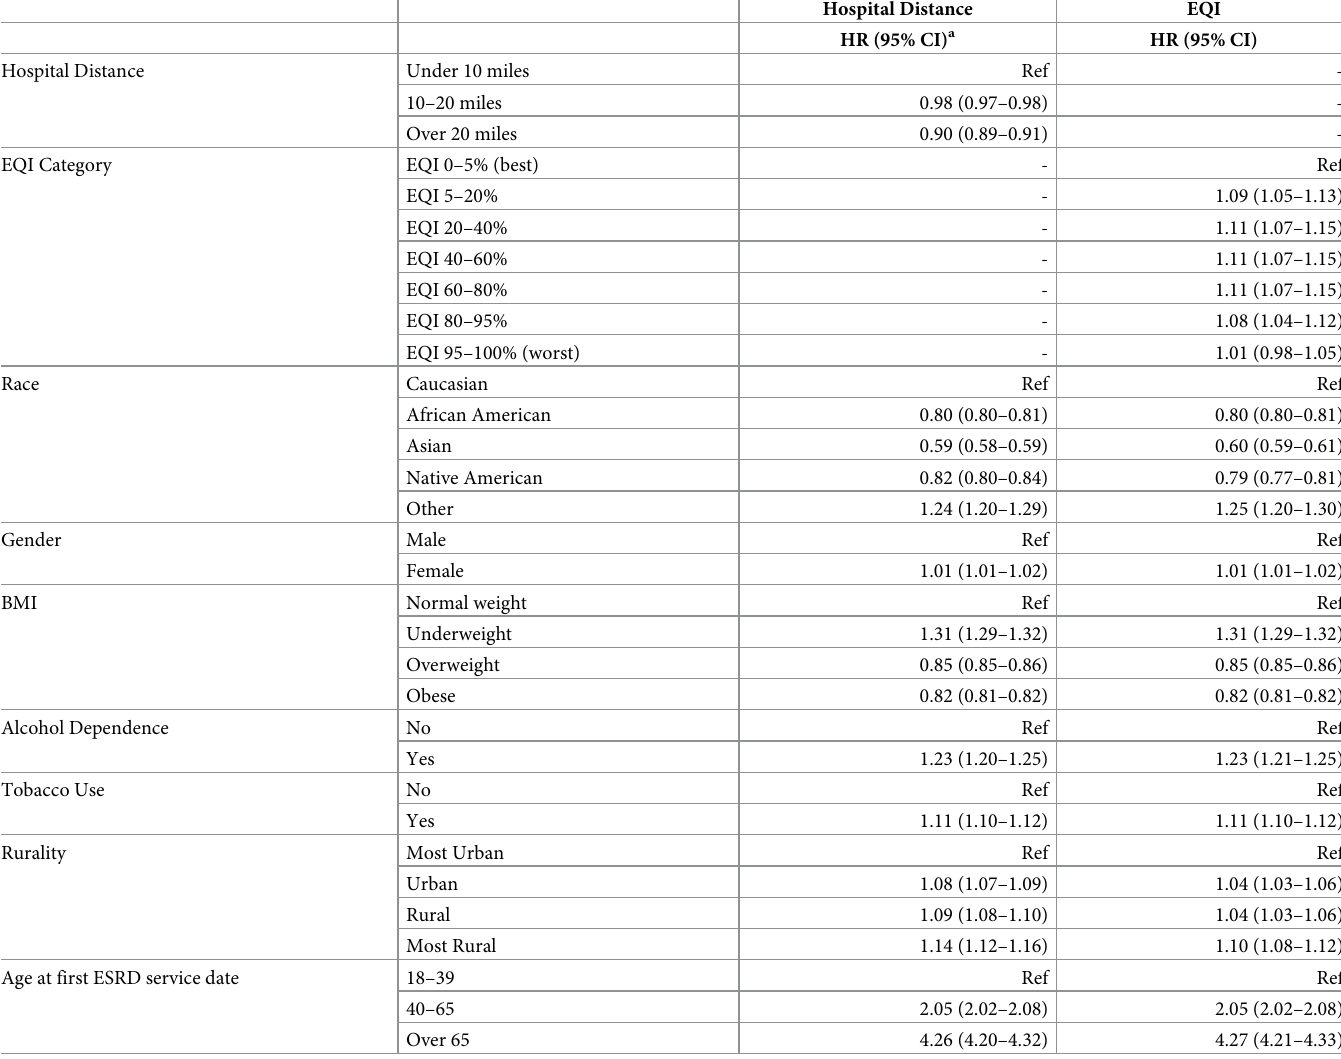
Table 2. Proportional hazard model results for ESRD survival by hospital distance and EQI (1,092,281 patients,